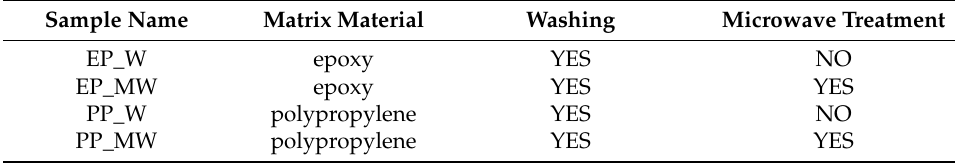
Table 1. Sample nomenclature used in the